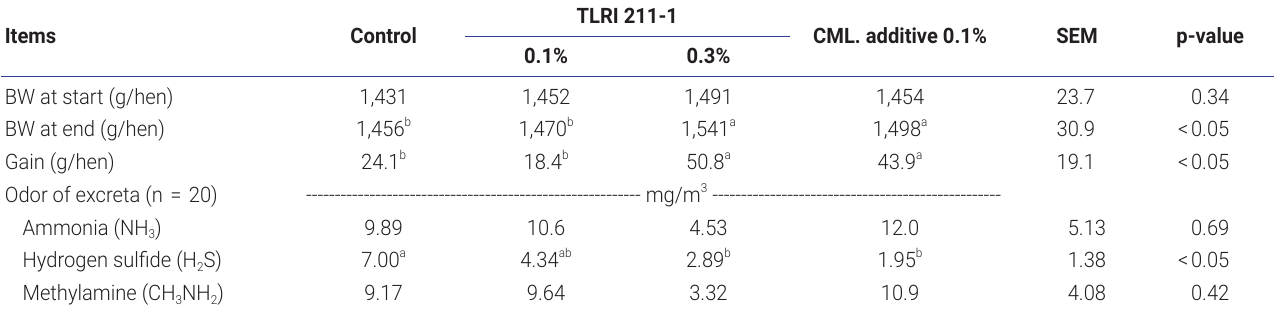
Table 2. Effects of dietary supplementation of Bacillus subtillis and B. amyloliquefaciens on body weight changes and excreta odor of Leghorn laying